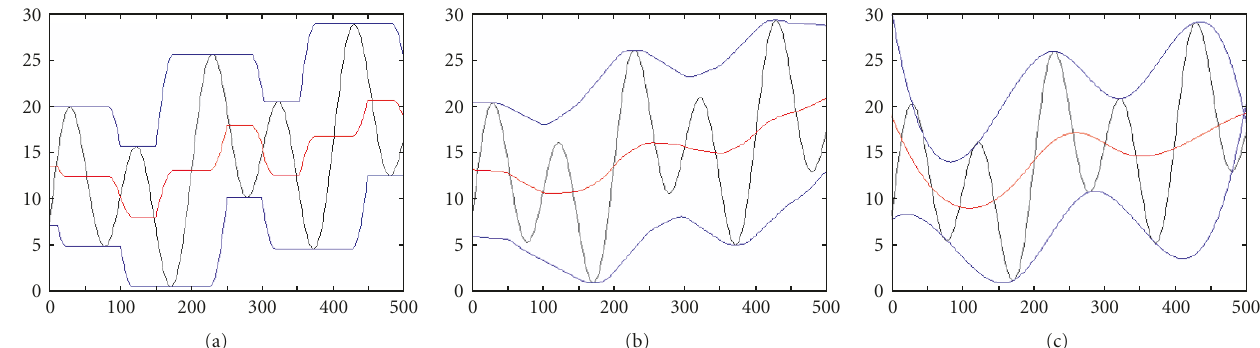
Figure 7: (a) Envelopes using the proposed approach before smoothing, (b) envelopes using the proposed approach after smoothing, (c) envelopes using cubic spline interpolation.